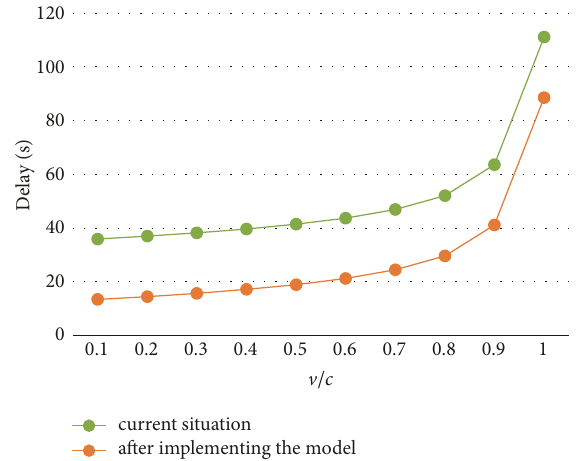
Figure 3: Comparison of private vehicles’ delay for the current sit- uation and the proposed presignal’s model with different 𝑉/𝐶 ratios at 𝑔/𝑐 = 0.5